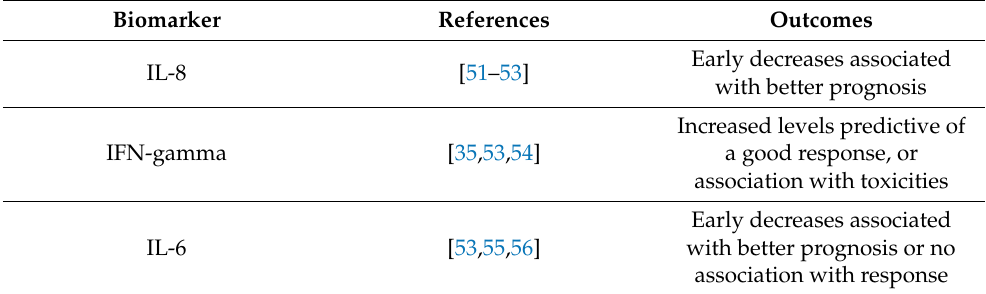
Table 3. Peripheral blood cytokines most studied and predictive values relative to ICI